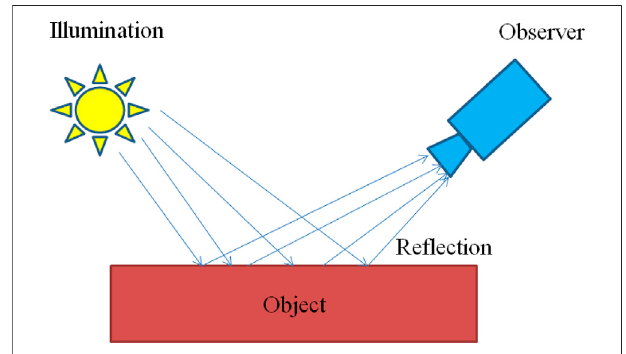
FIGURE 1 | Retinex